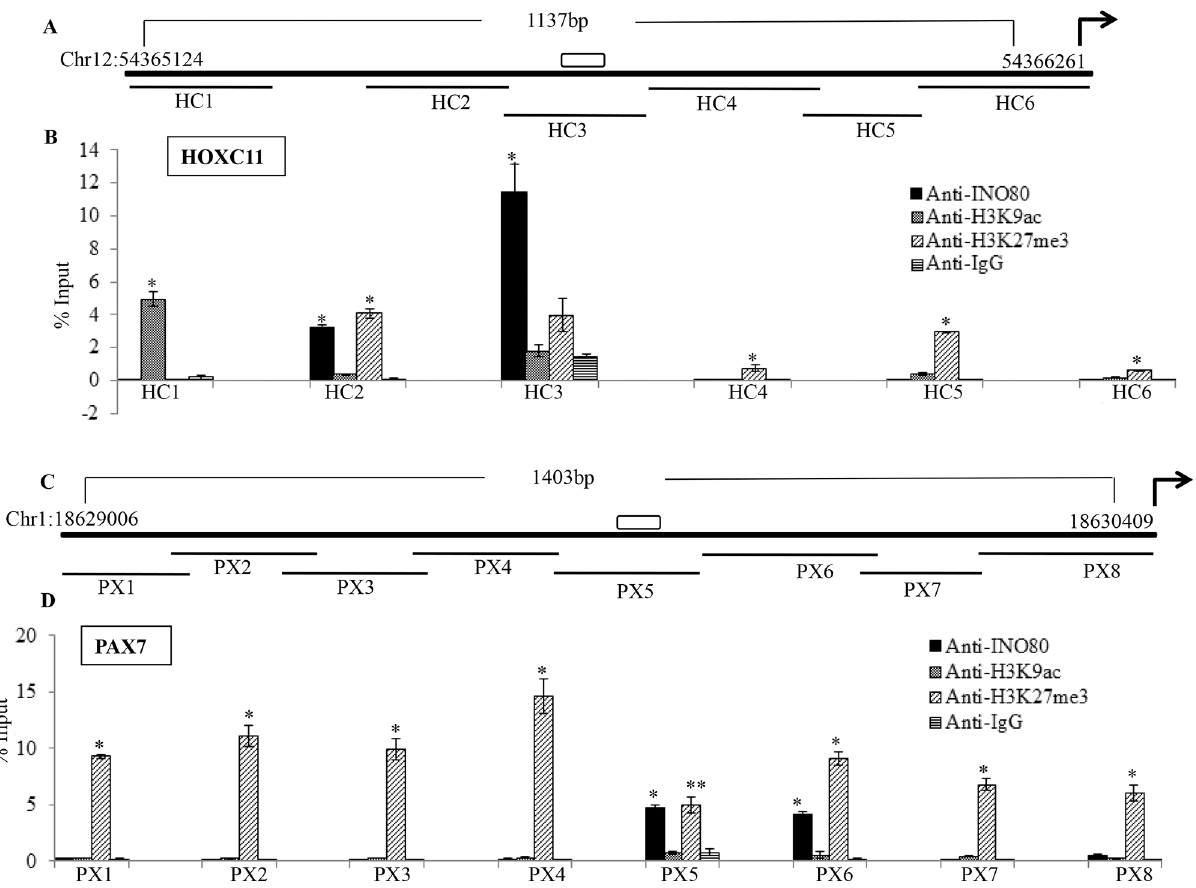
Fig 9. Localization of INO80 and histone marks in the upstream regions. The data from ChIP followed by qPCR for HOXC11(A & B) and PAX7(C & D) are shown. A & C- Line diagram indicates the upstream region analyzed by qPCR of ChIP DNA (thick black line) mapping on chromosome12 and 1 respectively for HOXC11 and PAX7 , along with the genomic positions; the bent arrow indicates the direction of transcription of the gene, and unfilled box is the hINO80 binding motif present in the upstream region. HC1-HC6 and PX1-8 are the amplicons originating from the upstream region covering 1137bp and 1403bp of HOXC11 and PAX7 respectively using primers listed (S2B Table). B&D show the enrichment as % Input for each region HC1-HB6(B) and PX1-PX8 (C) of INO80 and the H3K9me3 and K3K27me3 marks as shown in the inset ( * p value < 0.05 and ** p < 0.001 in comparison with IgG for each primer set).